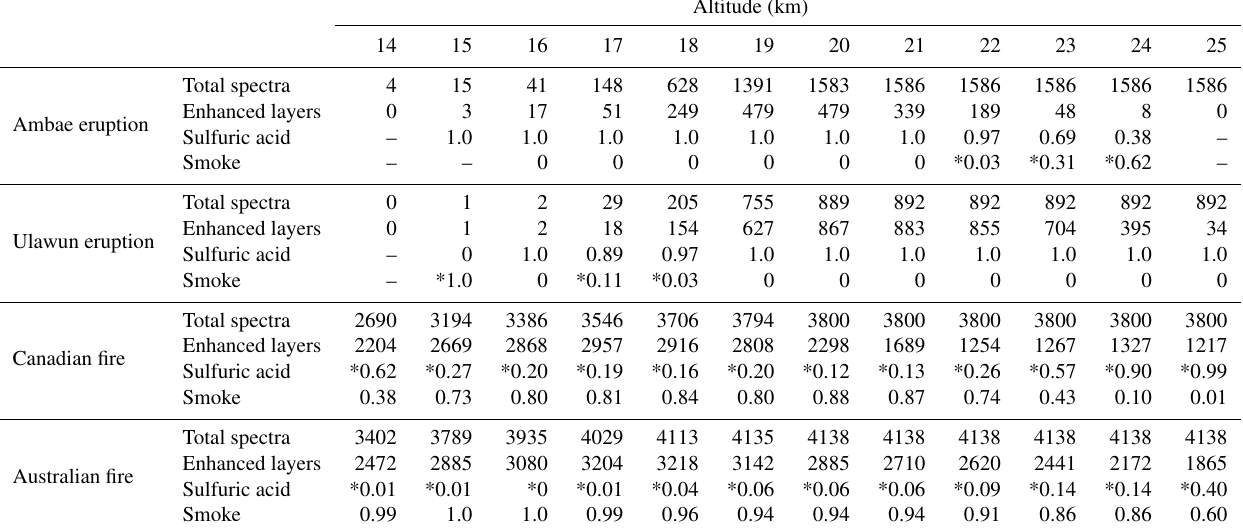
Table 3. Layer classification statistics from the SAGE data for the four case-study events. Total number of valid spectra, total number of identified layers, and the fraction of spectra identified as smoke or sulfuric acid aerosol for each case-study event. These case-study events were single-sourced, so the presence of smoke in volcanic events or enhanced sulfuric acid in wildfire events is expected to be negligible and would be considered misclassification. These potential misclassifications are labeled with an asterisk (*) for